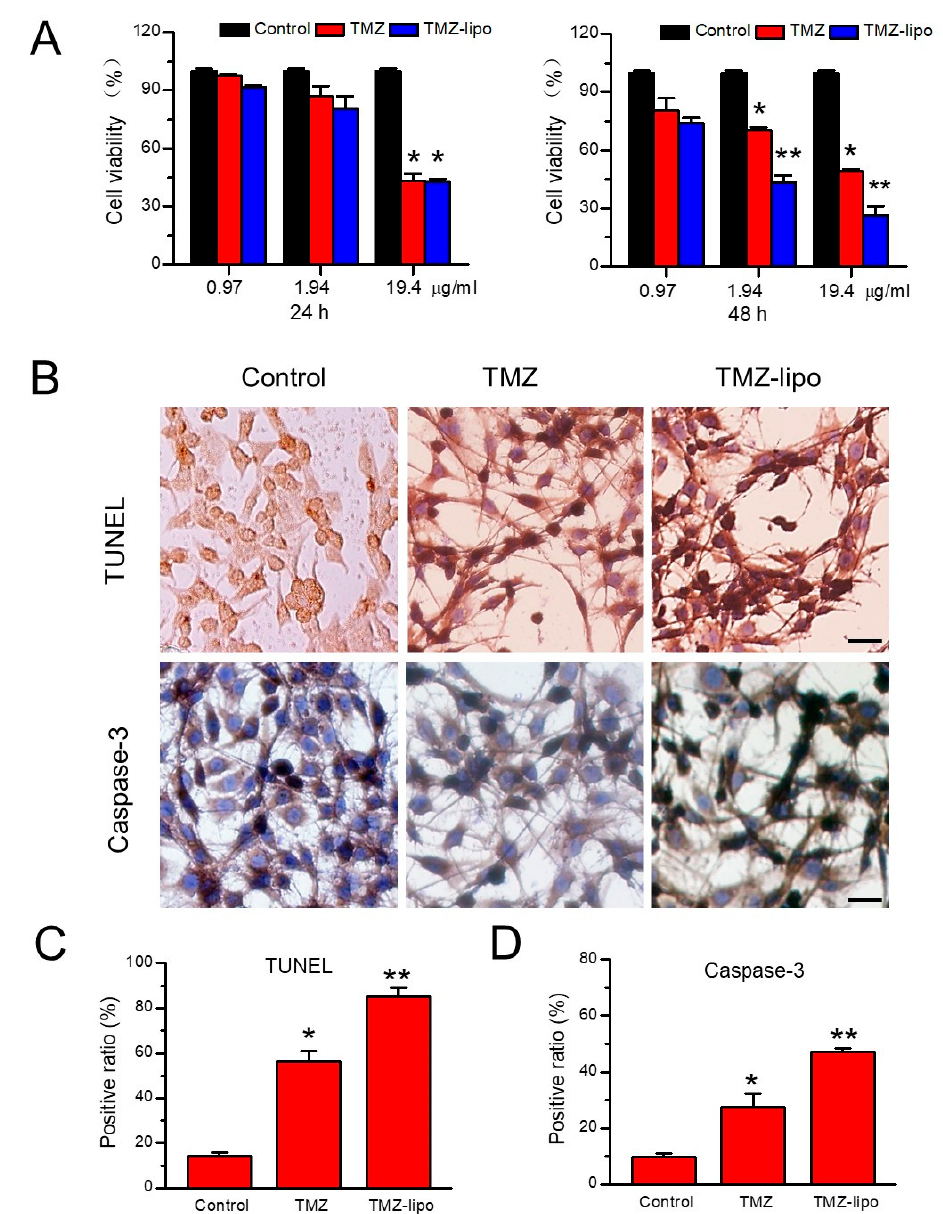
Figure 2. In vitro assay of TMZ-lipo. ( A ) CCK-8 assay showing that TMZ-lipo decreased C6 cell viability after 24 and 48 h. ( B ) Cell apoptosis assay by TUNEL and immunohistochemical staining of caspase-3 for cells treated with TMZ and TMZ-lipo after 48 h. Scale bar, 10 µ m, * p < 0.05, ** p < 0.01. ( C ) Percentage of TUNEL-positive cells. ( D ) Percentage of caspase-3-positive cells.